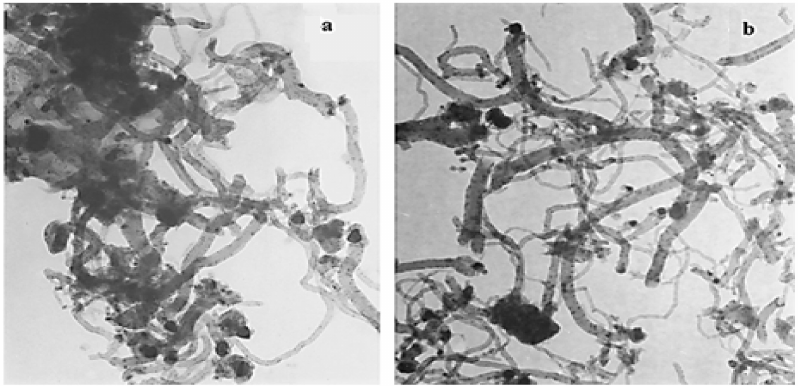
Figure 8. TEM images of carbon nanotubes obtained from methane cracking employing ( a ) pure Ni and ( b ) Ni–Cu; reprinted with permission from ref. [90]. Copyright 2010 Elsevier.